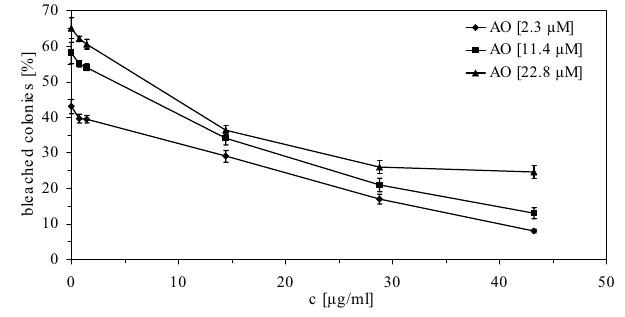
Figure 5 A plot of percentage of bleached colonies of E. gracilis vs. concentration of jatrorrhizine at 3 concentrations of acridine orange (AO). Symbols and brackets have the same meaning as in Fig. 2.